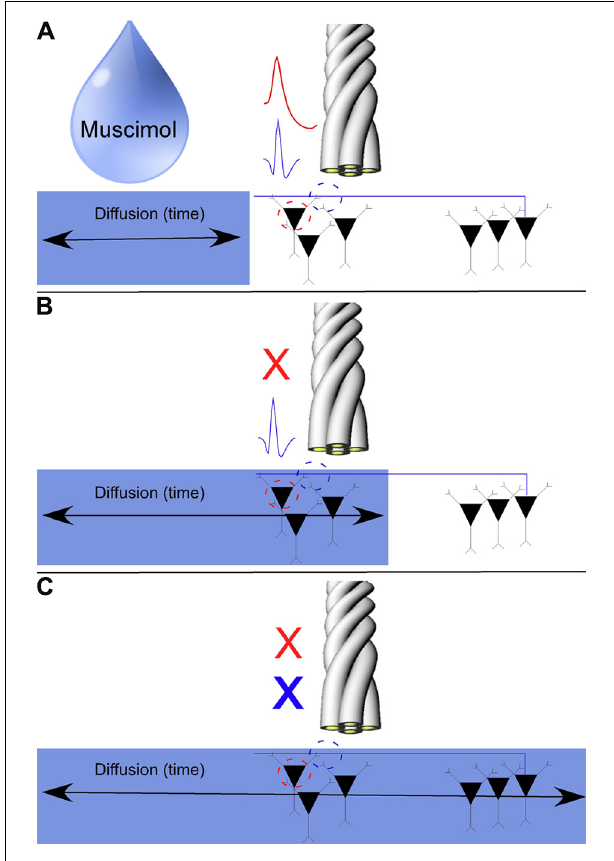
FIGURE 5 | Model for the pharmacological separation of putative axonal activity from somatic activity using the GABA A agonist Muscimol. As axons tend to have a sparse density of GABA A receptors, axonal activity should not be inactivated by local injections of Muscimol.We record somatic action potentials and SDWs simultaneously on the same tetrode (A) . Somatic action potentials are inactivated over time as Muscimol diffuses through the hippocampus (B) . If SDWs are truly representative of action potential propagation along axons (example SDW shown in blue), then Muscimol should inactivate local somatic activity when it diffuses to the recording site (example pyramidal waveform shown in red) while local SDW activity should persist (B) until sufficient diffusion time has elapsed for Muscimol to inactivate the distal somatic source of the axonal action potential (C)